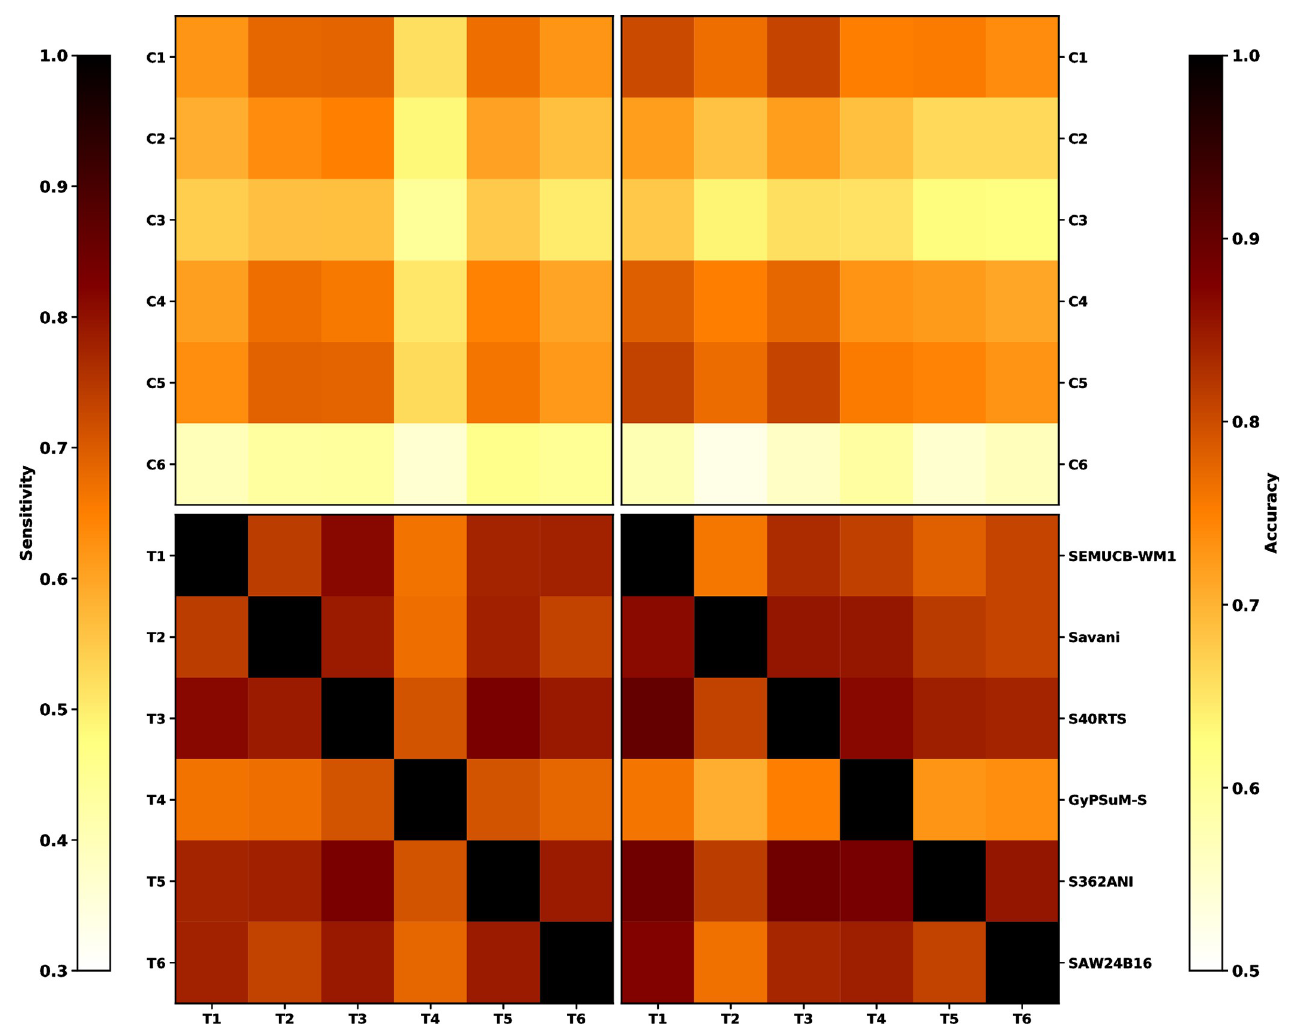
Fig 6. Quantitative match between predicted and imaged basal mantle structures. Match between hot basal mantle structures predicted by flow models and LLSVPs in seismic tomography models as mapped between 1,000 km and 2,800 km depths using cluster analysis. Left-hand-side panels show the sensitivity and right-hand-side panels the accuracy. In the top panels, quantities are derived between six flow models and six tomographic models, and in the bottom panels they are derived between six tomographic models.